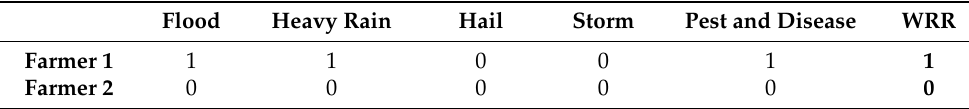
Table 3. Total scores of farmers’ risk perception of the weather-related risks. Flood Heavy Rain Hail Storm Pest and Disease